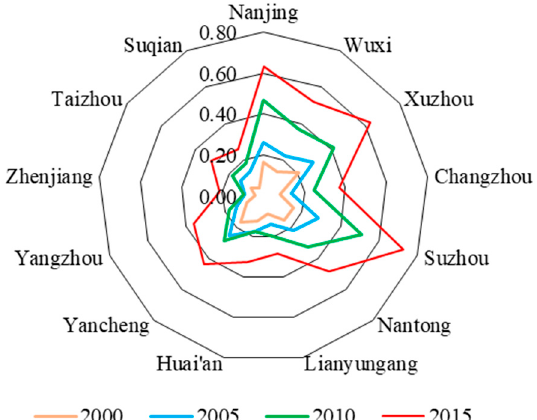
Figure 7. Radar charts of land use intensities of cities in Jiangsu province in 2000, 2005, 2010, and 2015 .